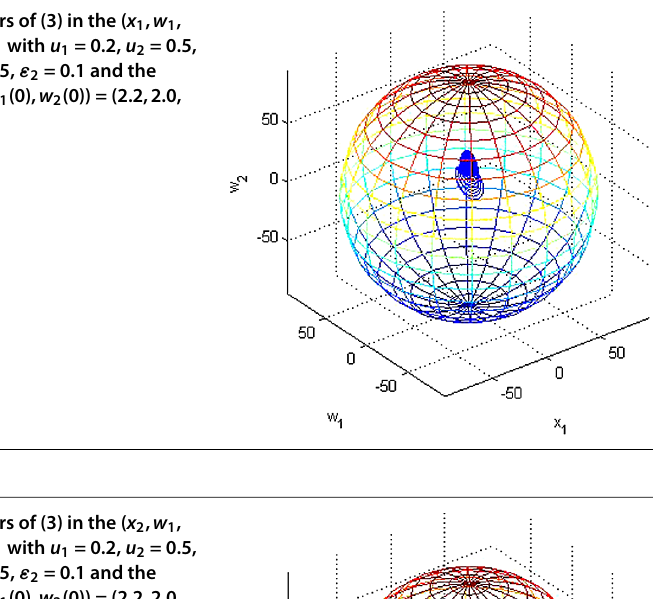
Figure 9 Chaotic attractors of (3) in the ( x 2 , w 1 ,